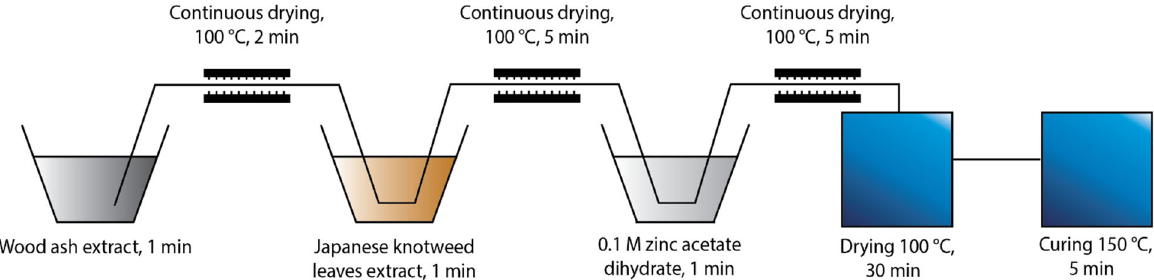
Figure 1. Schematic presentation of the Ash + Extr + 0.1 ZnAc protocol of the in situ synthesis of ZnO-NP on cotton.